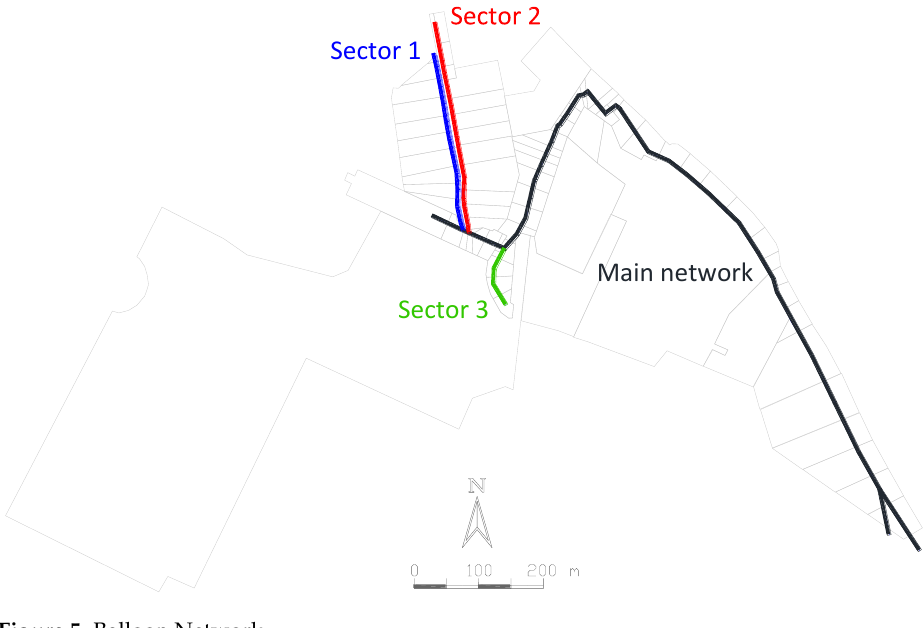
Figure 5. Balloon Network.